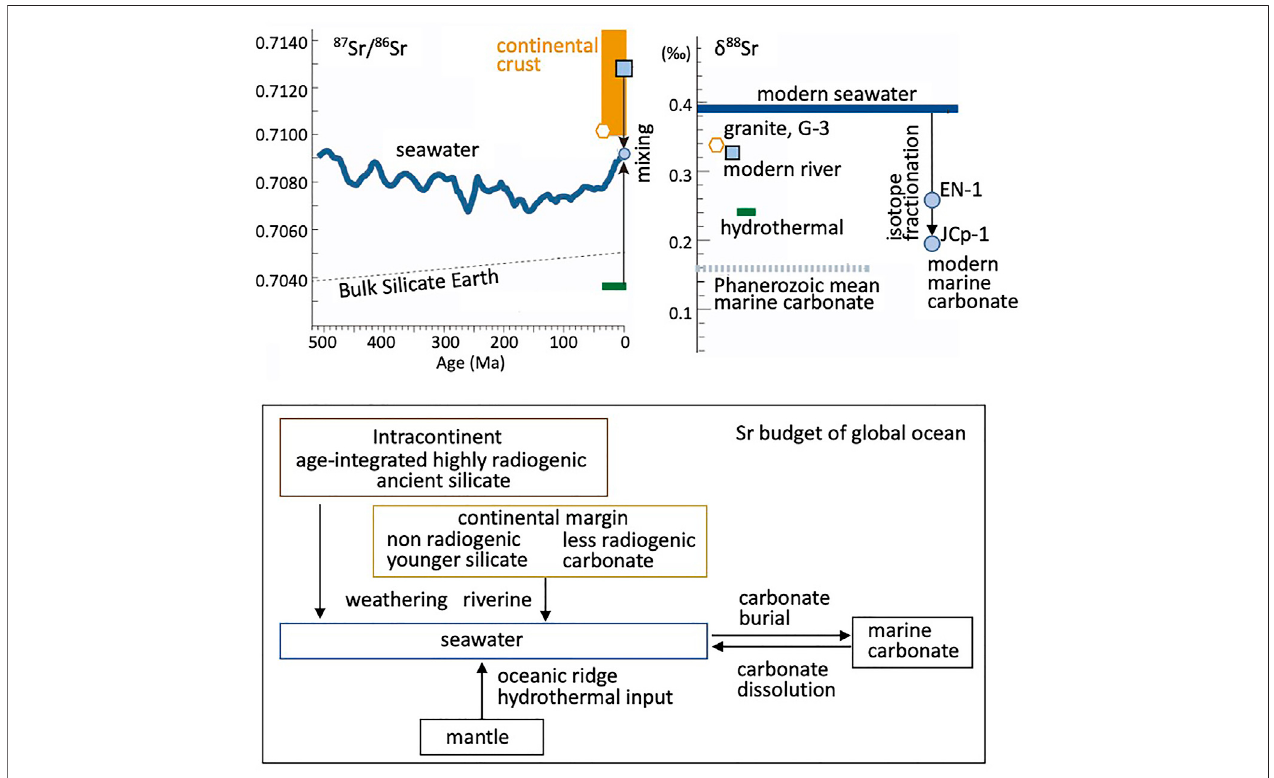
FIGURE 4 | Box model for the Sr budget of the global ocean, 87 Sr/ 86 Sr and δ 88 Sr values of natural samples. The model scheme for the oceanic Sr budget was modi fi ed from Vollstaedt et al. (2014). 87 Sr/ 86 Sr and δ 88 Sr values of modern seawater, modern oceanic carbonates (EN-1: modern giant clam shell, and JCp-1: coral), a granite rock standard sample (G-3), continental crust, modern rivers, hydrothermal water, and the Phanerozoic mean of marine carbonates are from Krabbenhöft et al. (2010), Moynier et al. (2010), Charlier et al. (2012), Neymark et al. (2014), Vollstaedt et al. (2014), and Pearce et al. (2015).